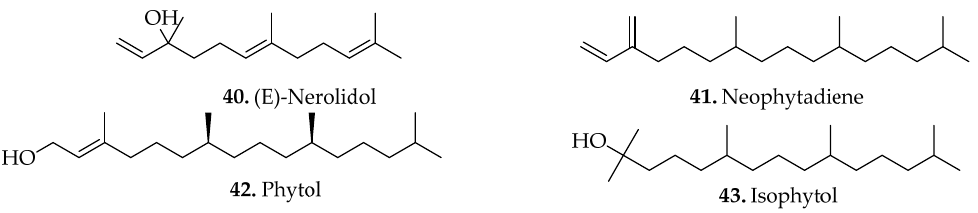
Figure 7. Chemical structures of terpenoids isolated from Blechnum species.